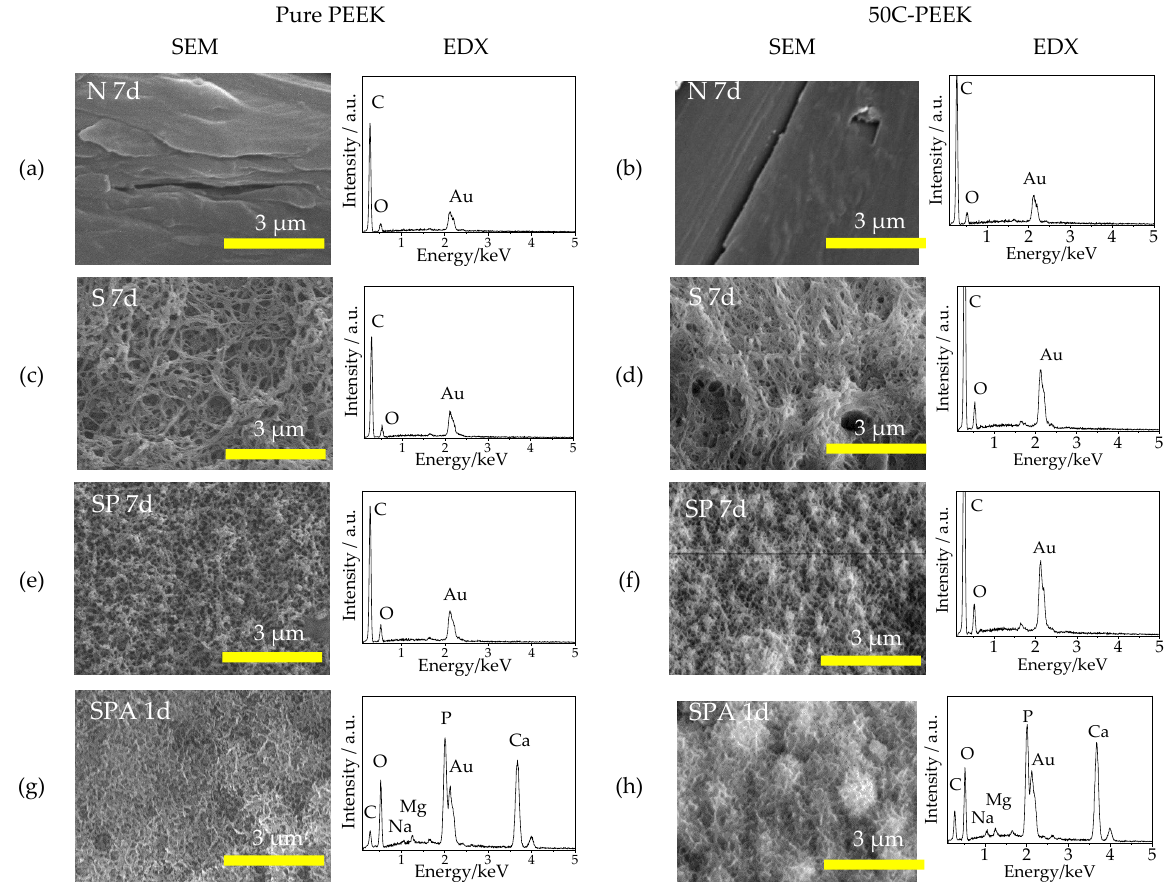
Figure 4. SEM micrographs and EDX profiles of the surfaces of Samples ( a,b ) N: untreated PEEKs after immersion in SBF for 7 days, ( c,d ) S: sulfuric acid-treated PEEKs after immersion in SBF for 7 days, ( e,f ) SP: sulfuric acid + oxygen plasma-treated PEEKs after immersion in SBF for 7 days, and ( g,h ) SPA: sulfuric acid + oxygen plasma + modified-SBF-treated PEEKs after immersion in SBF for 1 day for ( a,c,e,g ) pure PEEK and ( b,d,f,h ) 50C-PEEK .